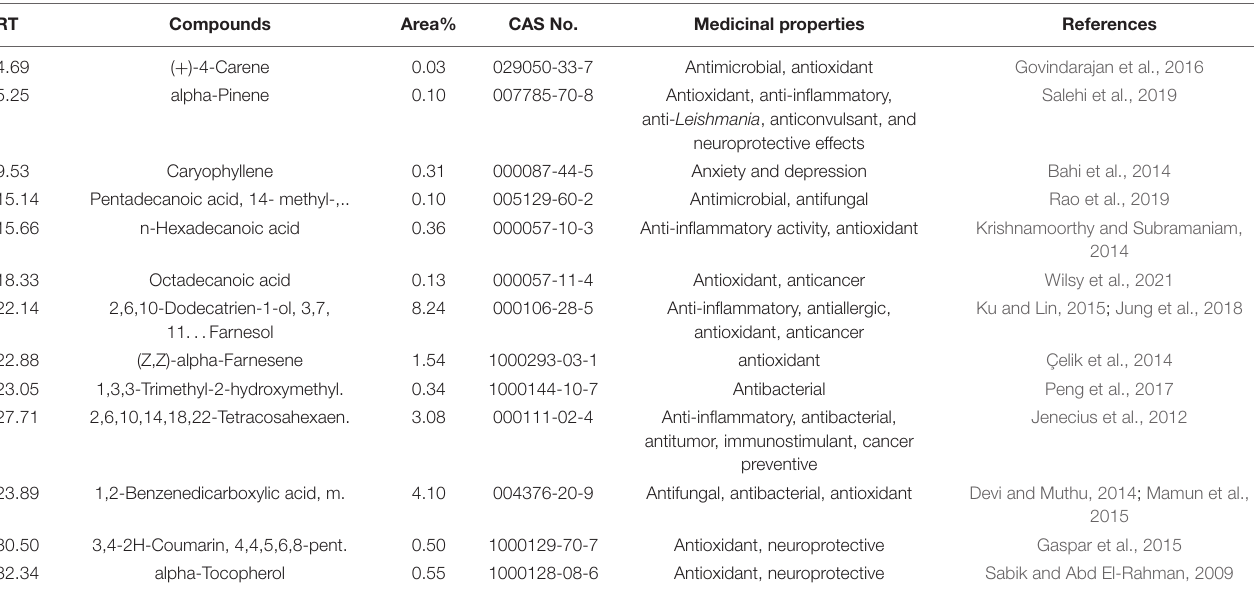
TABLE 3 | GC-MS analysis of bioactive constituents of methanolic extract of O.